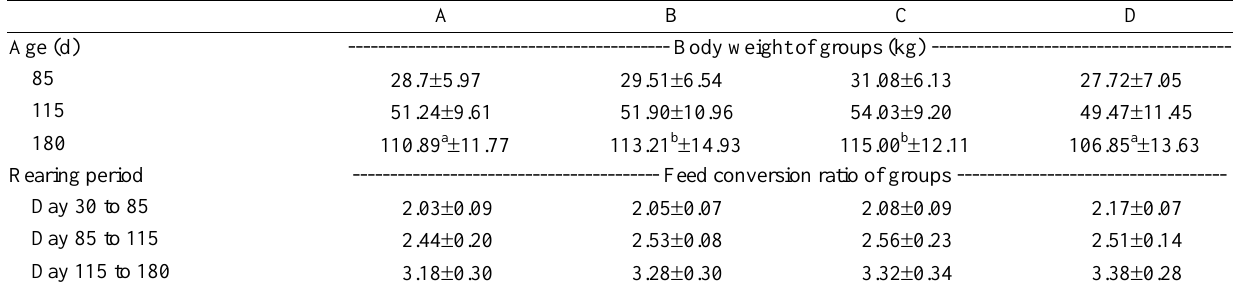
Table 2. Effect of dietary carob pods on pig body weight and feed conversion ratio (Mean  SD) A B